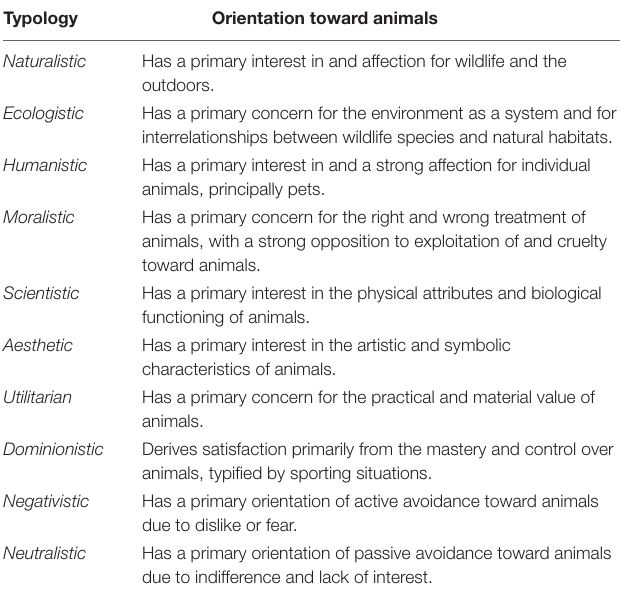
TABLE 2 | Summary of the basic attitude typologies toward animals as defined by Kellert